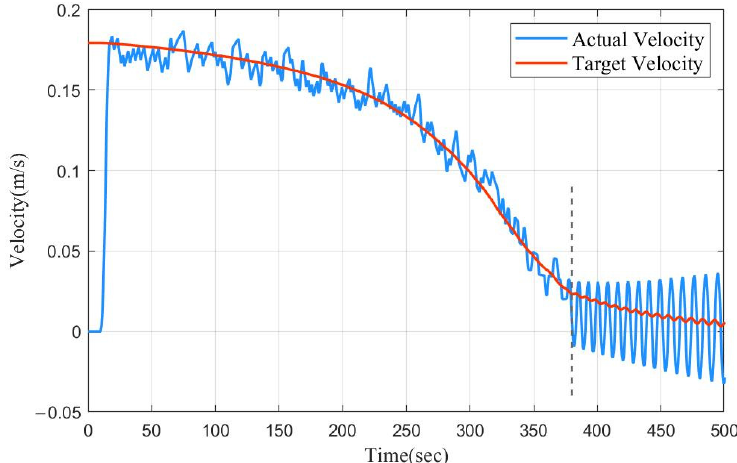
Figure 6. Speed tracking in depth control by segment PD control (target depth was 50 m).